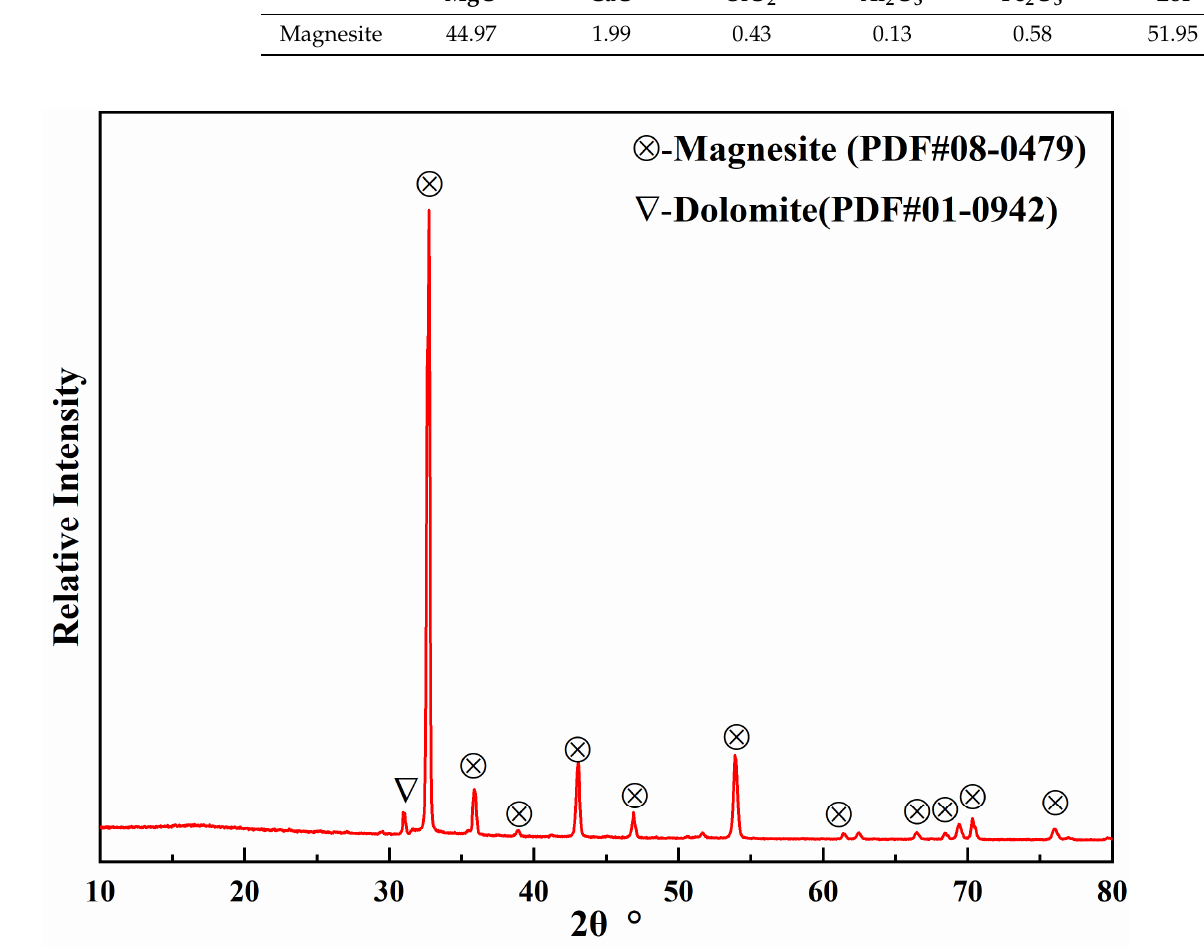
Figure 1. Diffraction results for the